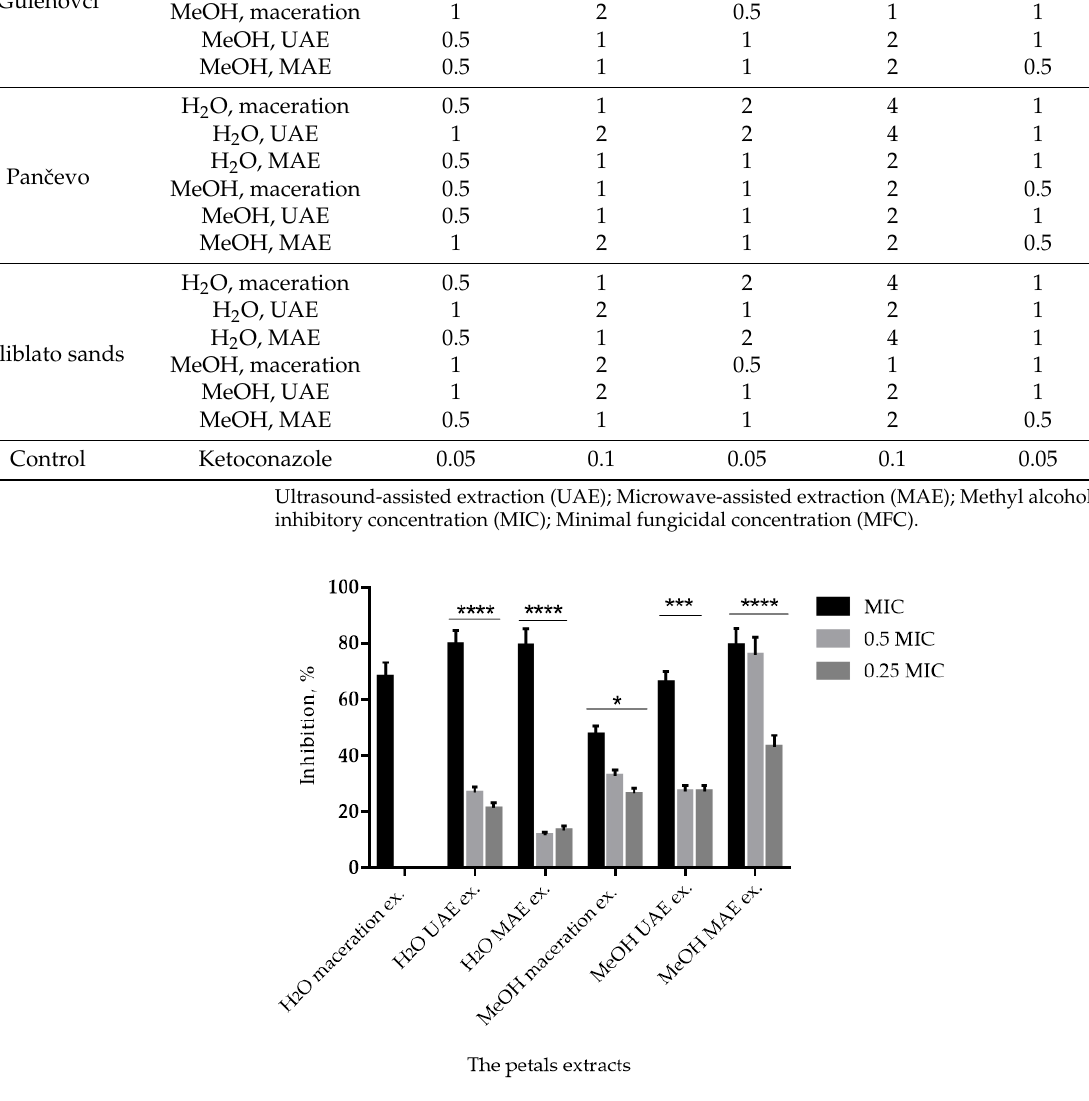
Figure 1. Biofilm formation of S. lugdunensis (Ibis 2996) after treatment with P. tenuifolia extracts. The asterisks represent statistical significance: * p ≤ 0.05; ***, p ≤ 0.001, ****, p ≤ 0.0001.